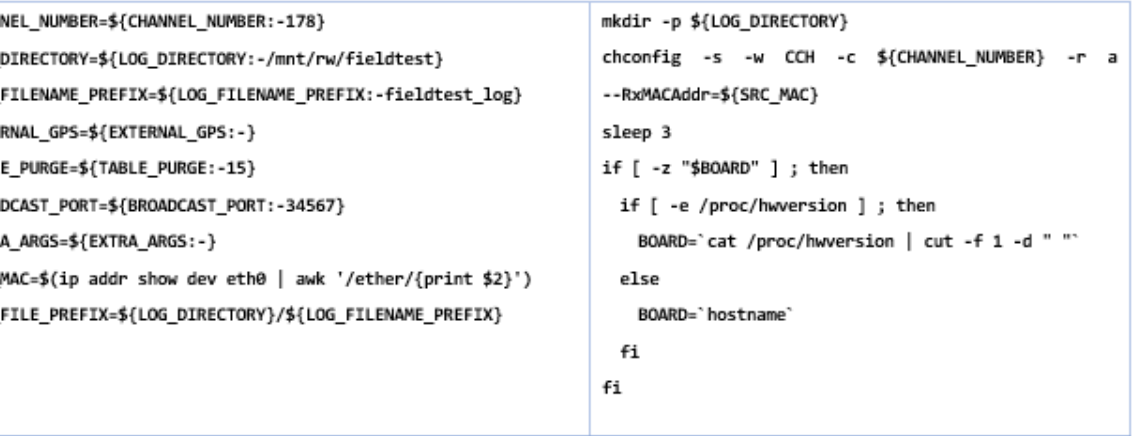
Figure 20. GPS and IP/MAC communication and activation procedure.